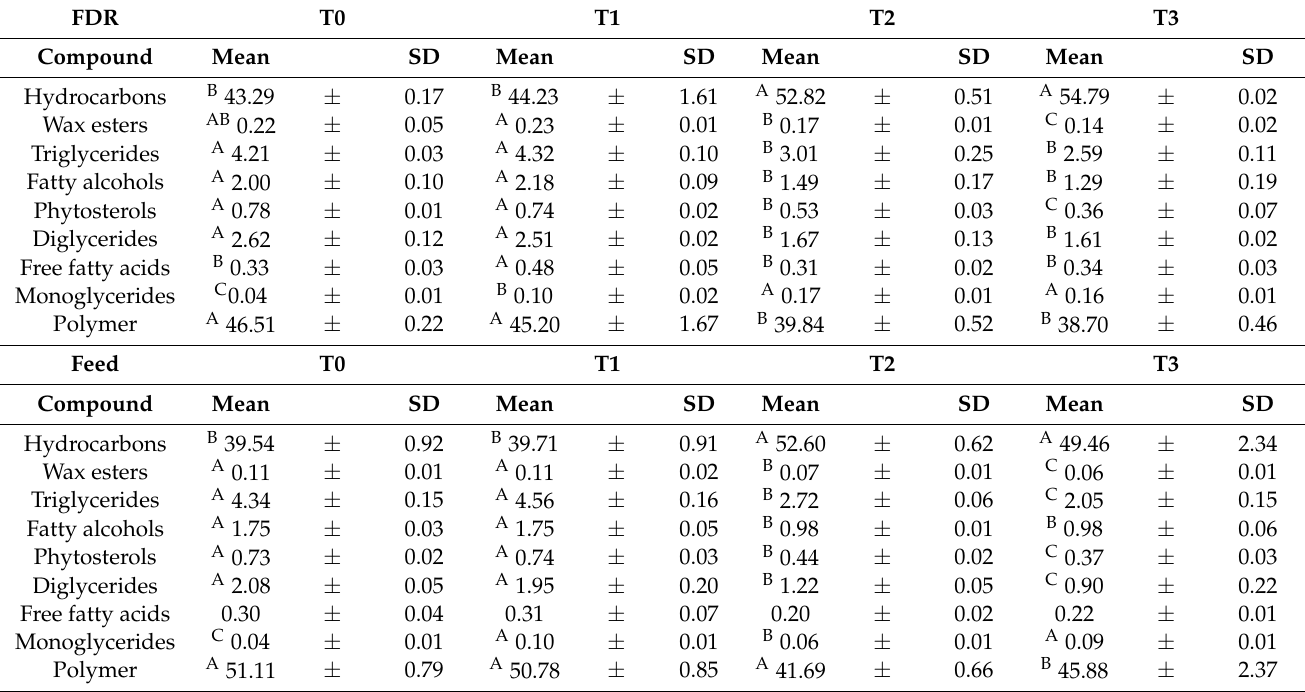
Table 1. Lipid class compositions (g/100 g of lipids) of the FDR and feed samples at the different assay times.